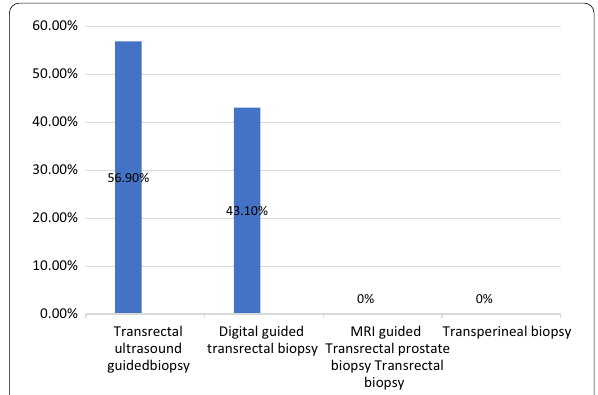
Fig. 3 Bar chart depicting the techniques of prostate biopsy